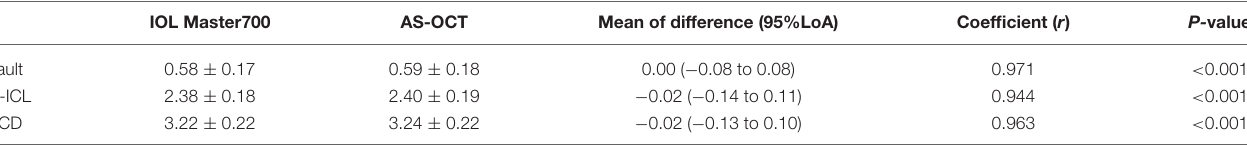
TABLE 4 | Agreement and correlations among parameters measured using the IOL Master700 and